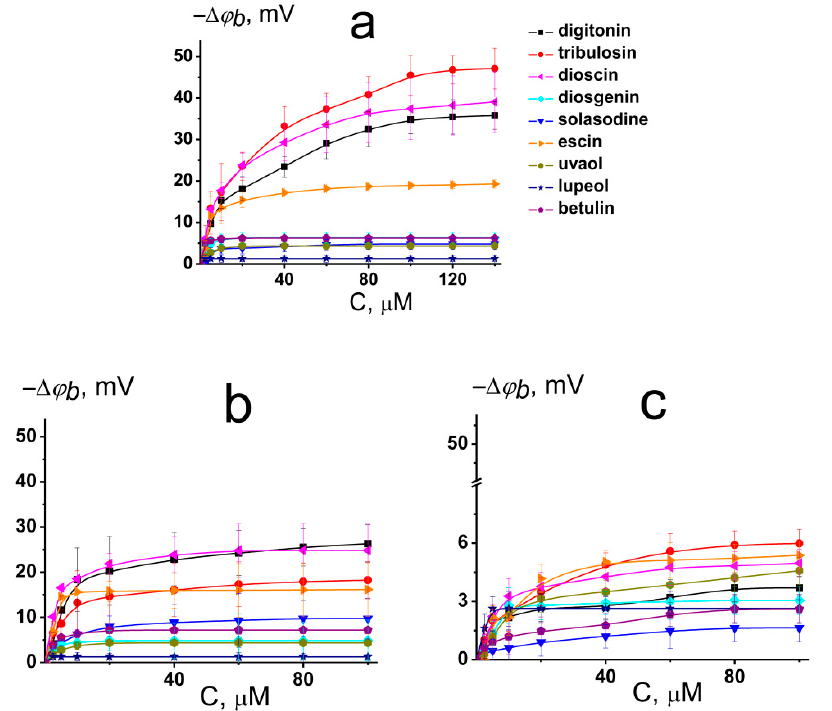
Figure 2. Dependence of the decrease in the boundary potential of the membrane ( − ∆ ϕ b ) on the concentration ( C ) of different saponins and related compounds in the membrane bathing solution. The membranes were made from DPhPC ( a ), DPhPC/CHOL ( b ) and HOPC ( c ), bathed in 0.1 M KCl (pH 7.4), and modified by nonactin. V was equal to 50 mV. The relation between the color symbol and the compound is given on the figure.